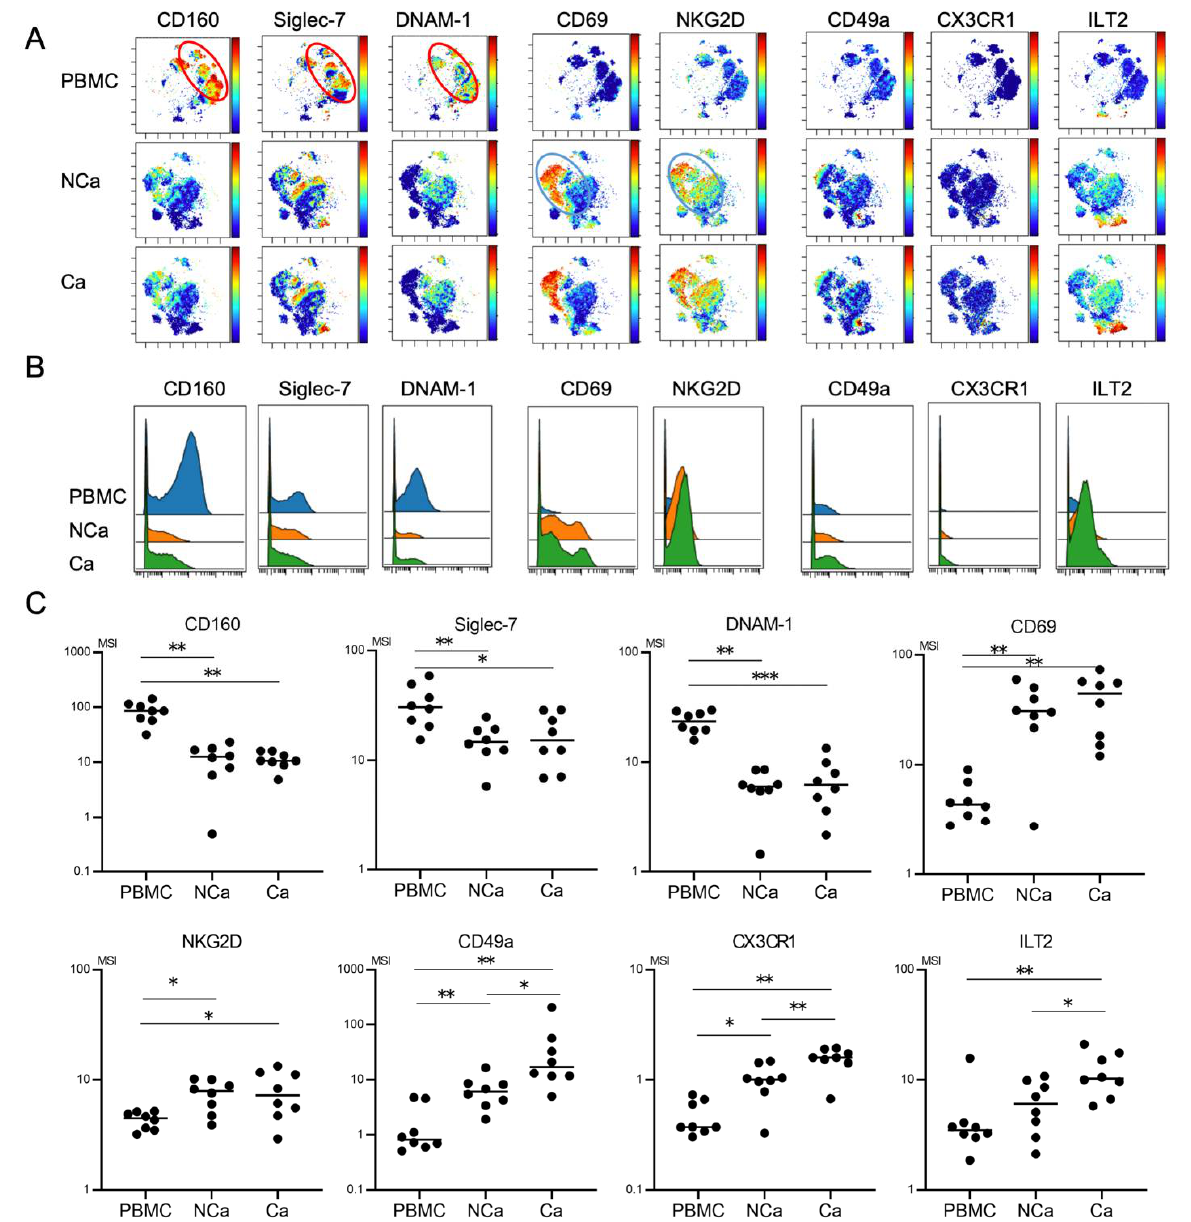
Figure 4. Comparison of phenotypic characterization between peripheral and intrahepatic NK cells from HCC patients. ( A ) Representative viSNE plots of peripheral and intrahepatic NK cells (CD45 + CD3 − CD14 − CD19 − CD56 + ) from HCC patients. Each panel shows expression of the indicated surface protein. The color scale indicates a gradient of high (red) to low (blue) expression of the relevant protein. PBMC, peripheral blood mononuclear cell; NCa, intrahepatic lymphocytes from non-cancerous adjacent liver tissues; Ca, intrahepatic lymphocytes from HCC tissues. ( B ) Representative histograms showing expression of the indicated cell surface protein in peripheral and intrahepatic NCa-and Ca-NK cells from HCC patients. ( C ) Quantification of CD160, Siglec-7, DNAM1, CD69, NKG2D, CD49a, CX3CR1, Siglec-10, ILT2, and PD-1 expression (MSI) on peripheral, intrahepatic NCa- and Ca-NK cells. * p < 0.05; ** p < 0.01 by the Kruskal–Wallis test with Dunn’s multiple comparison test.